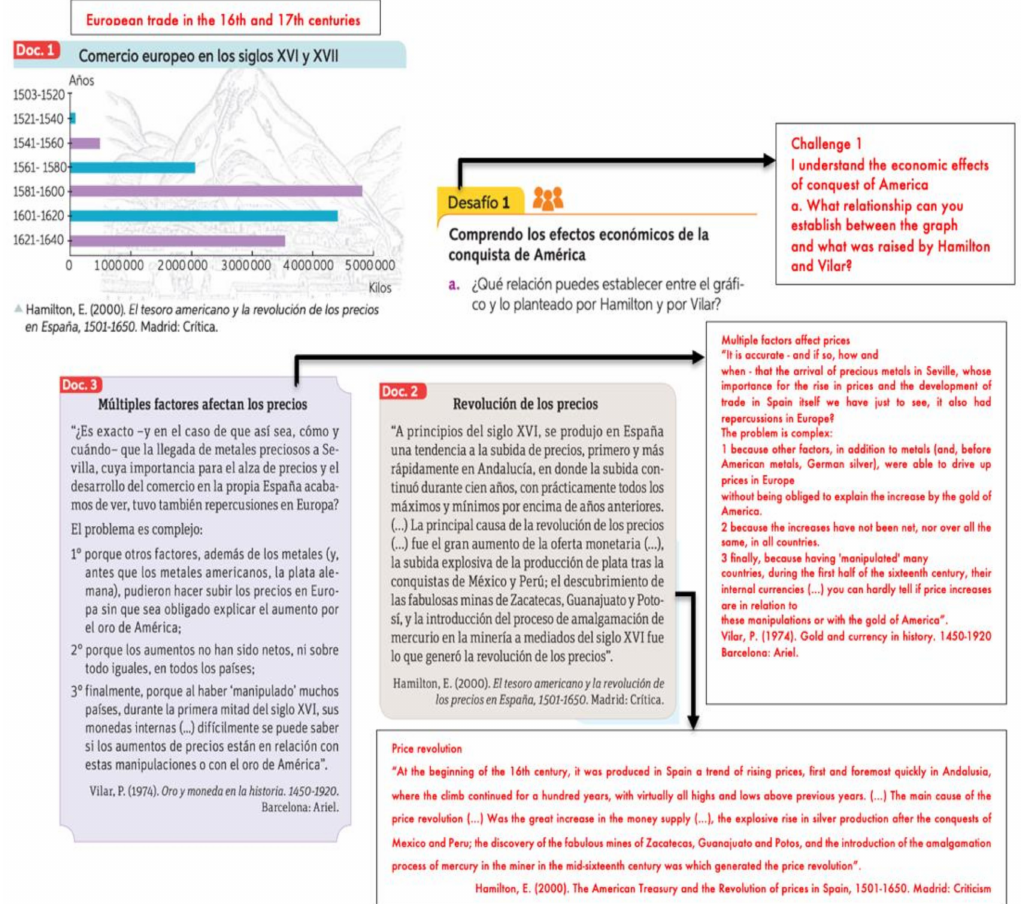
Figure 16. Example of initial mixed representation, 8th Grade (Adapted from [39] (p.